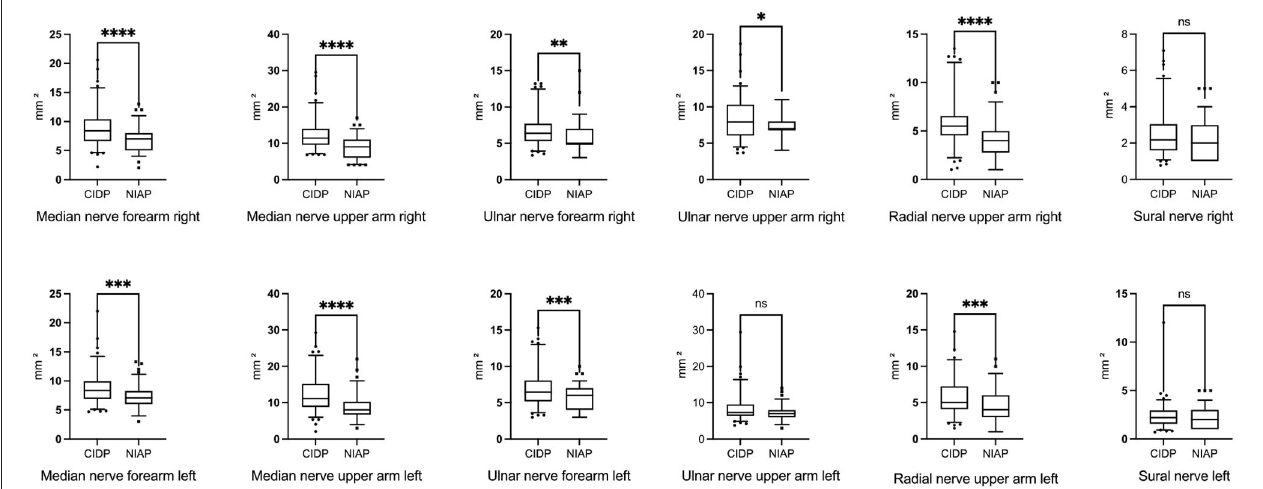
FIGURE 1 | Boxplots of CSA values of all nerve sites showing larger nerve sizes of all examined nerve sites in patients with CIDP compared to patients with NIAP. Differences were statistically significant except in the sural nerve and left ulnar nerve in the upper arm. Corresponding CSA and SD are given in Table 3 . * p < 0.05; ** p